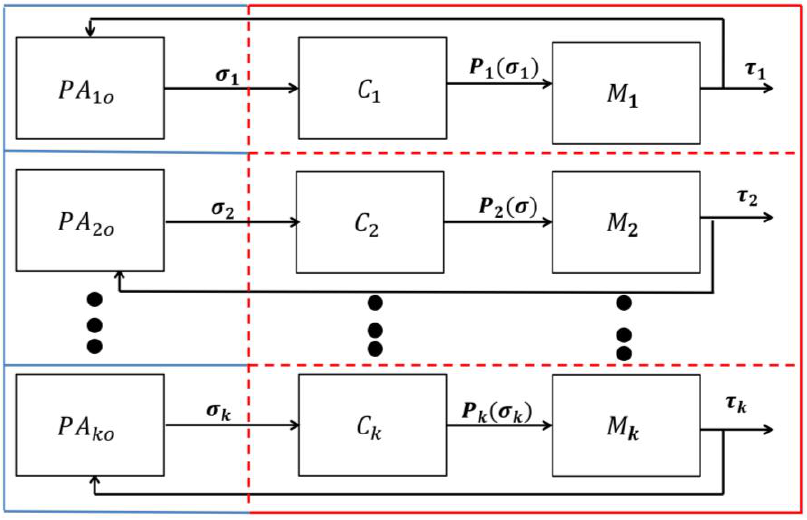
Figure 3. The components of an inquirer subsystem (within the red box) and initiator subsystem (within the blue box). The components 𝑷𝑨 𝒊𝒐 , 𝑪 𝒊 and 𝑴 𝒊 form a monitoring agent ( i ) with a reporter.